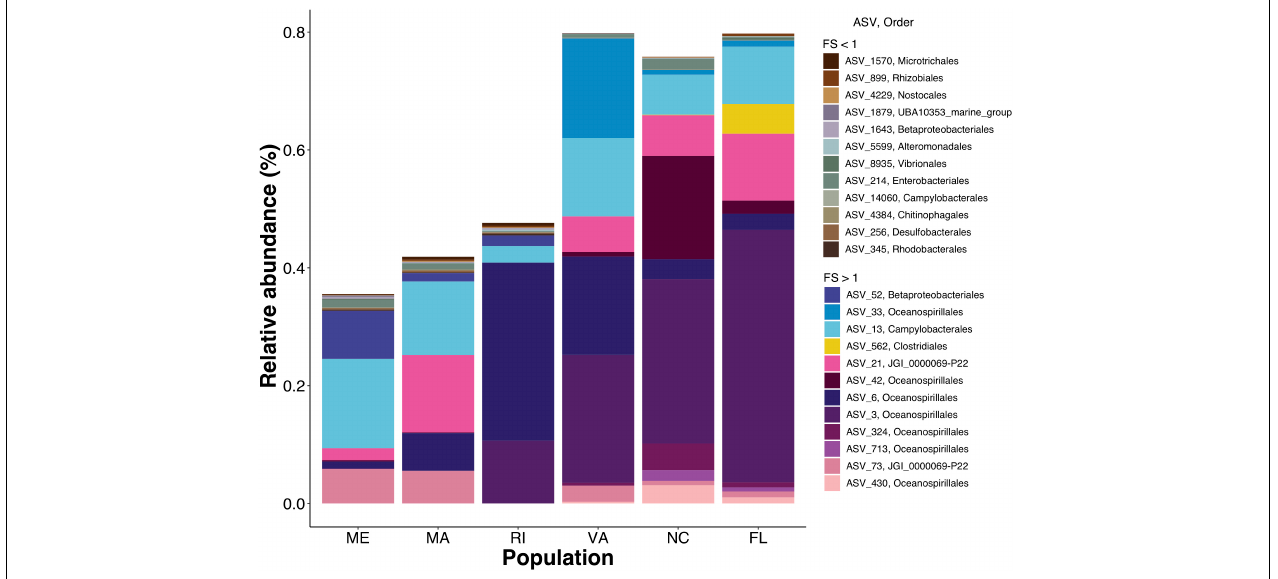
FIGURE 6 | Staked bar plot of the mean relative abundances by population of ASVs with the top and bottom 1% FS. Earth tones represent ASVs with FS < 1 vibrant colors represent FS > 1. Detailed taxonomic information for these ASVs available in Supplementary Table 3 .